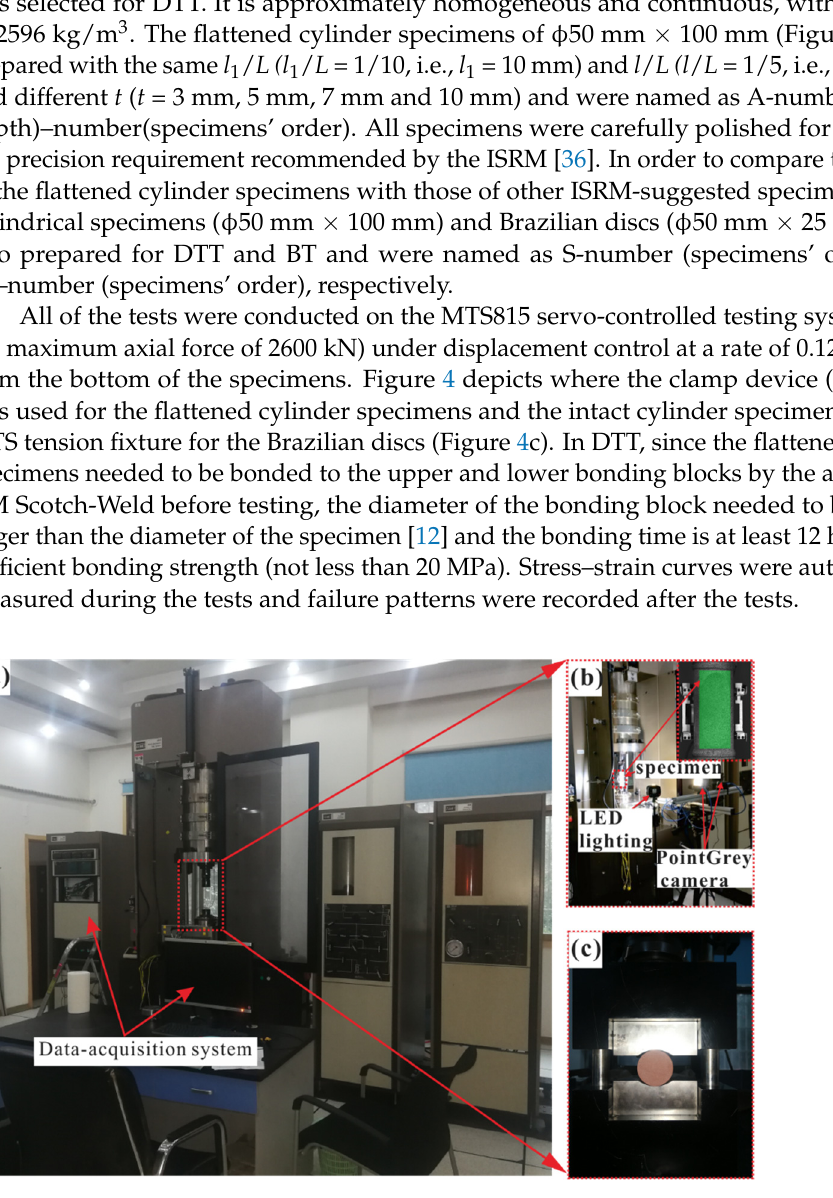
Figure 4. Test machine and loading setups: ( a ) MTS815 test system, ( b ) the direct tensile test with digital image correlation, ( c ) Brazilian test through MTS tension fixture.